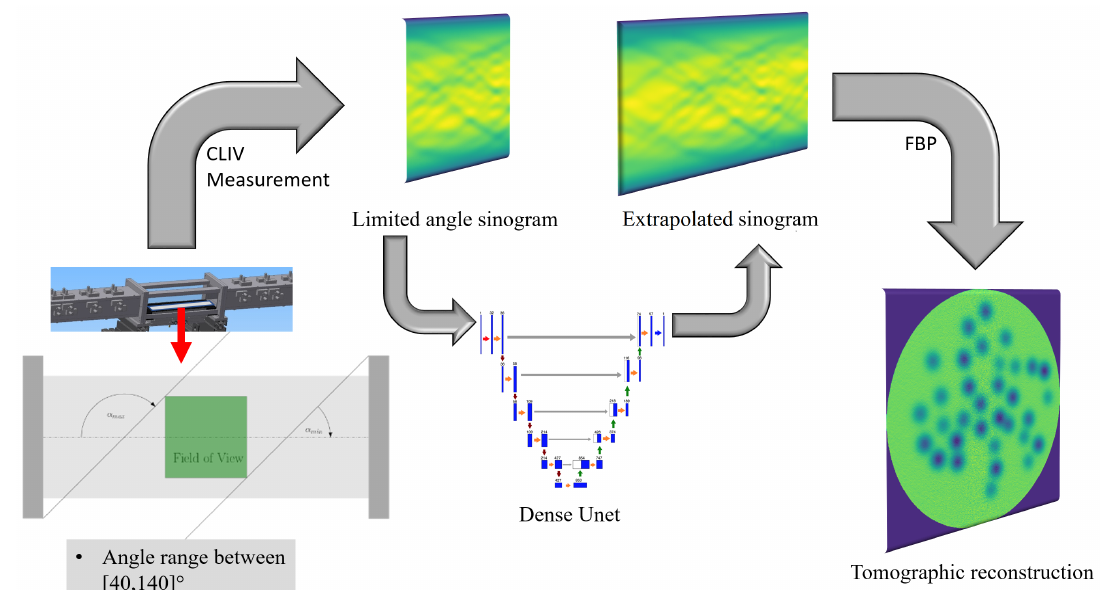
Figure 7. Flow chart for processing limited angle tomography: Projection data are recorded holograhically with limited angle (LA) access and assembled into a sinogram. The limited angle sinogram is fed into a pretrained dense Unet and the missing projection data are extrapolated. Filtered back projection is then used to calculate the local